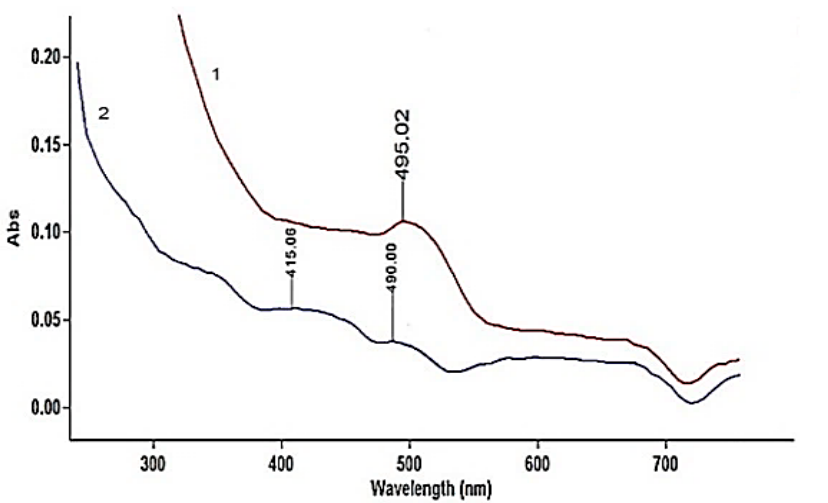
Figure 10. UV-Vis absorption spectra of samples from subsequent sewing interventions: 1- Sample 9 , 2- Sample 10 (Velum) .